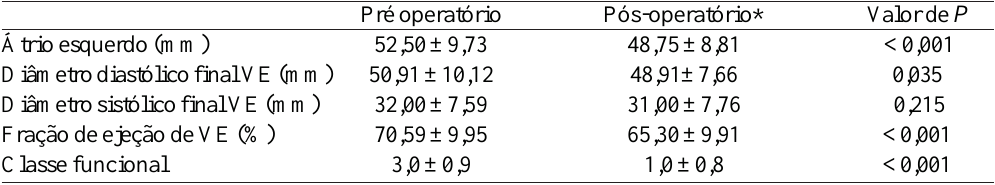
Tabela 1. Dados ecocardiográficos pré e pós-operatórios.